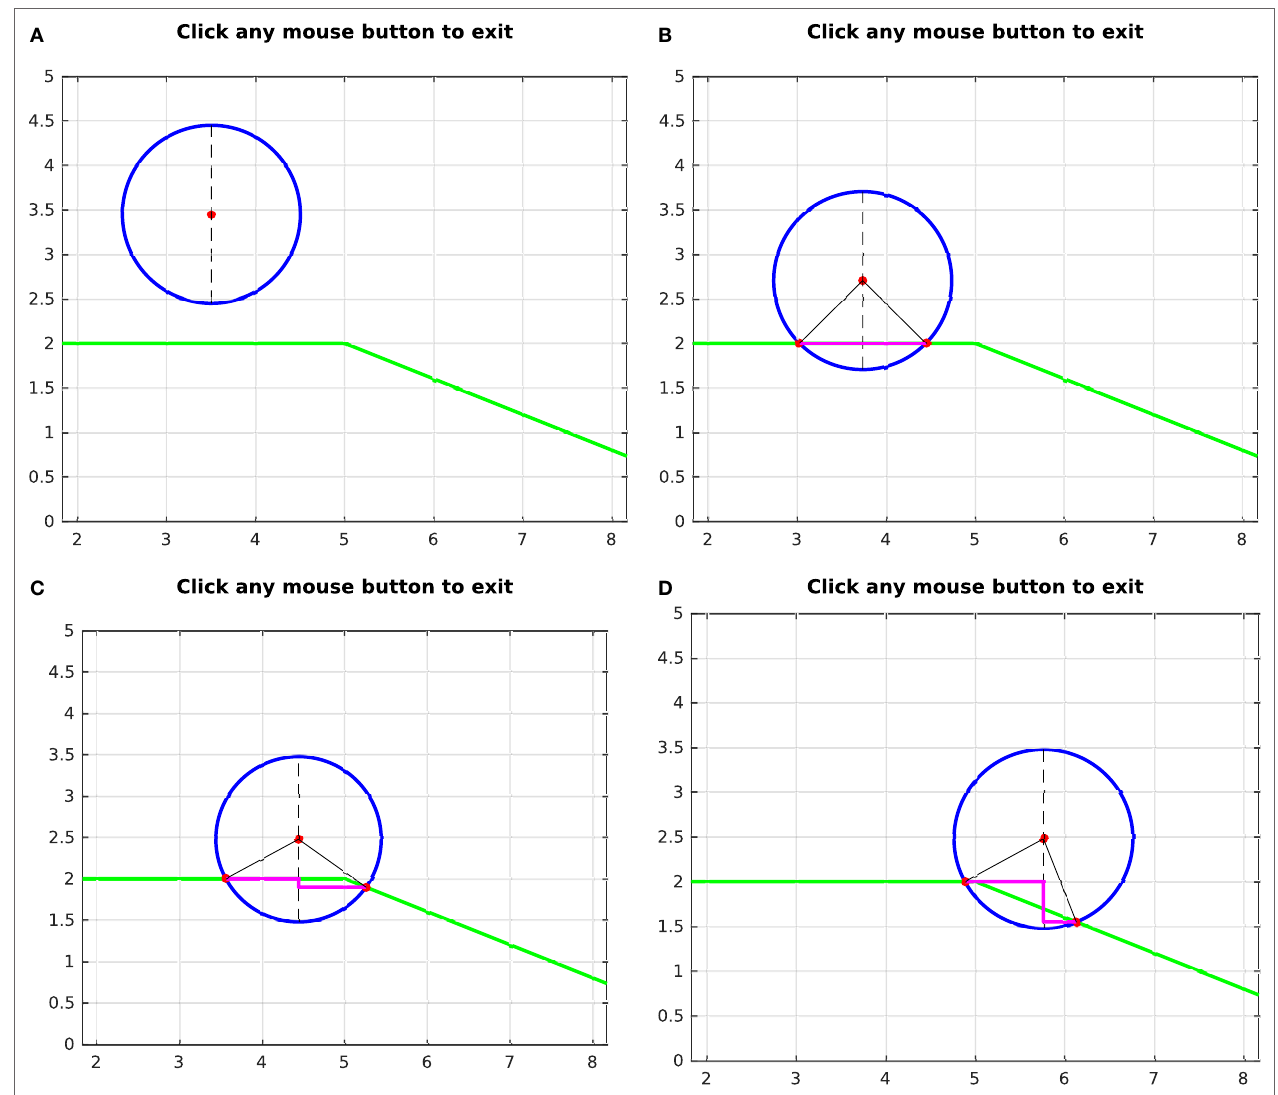
FIGURE 9 | The insertion of the SPR into mesh environment causes the contact points to slide along the mesh face based on ∂ x , shown in (A,B) . In (C,D) , as the SPR slides between two mesh faces along the direction of the previous mesh face, the new mesh face causes the contact point to change based on ϕ f